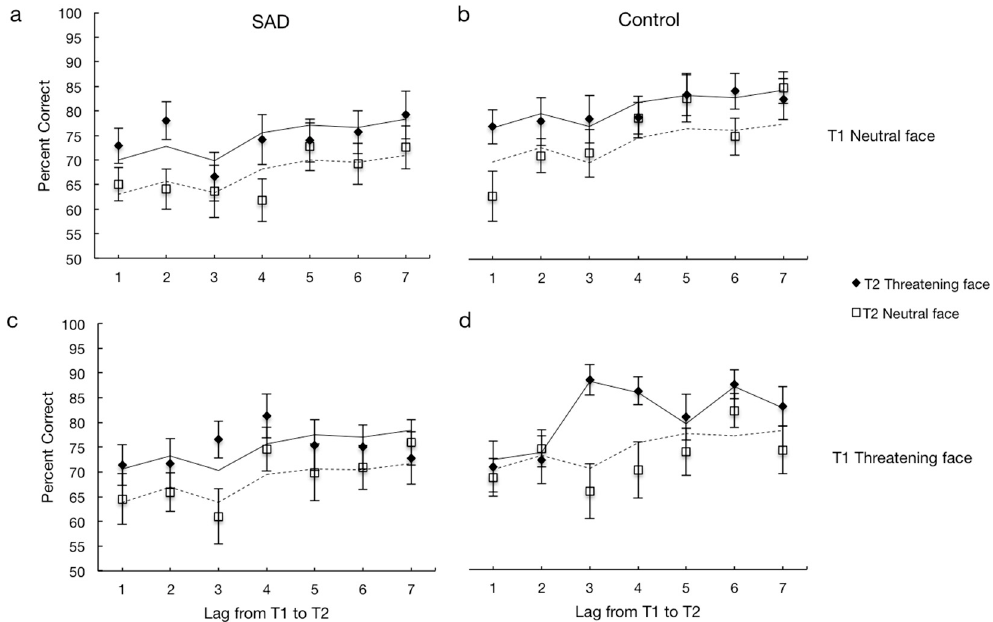
Figure 3. The results for the attentional blink task showing accuracy for T2 when T1 was correct for the SAD group when T1 was neutral ( a ) and when T1 was threatening ( c ), and for the healthy control group when T1 was neutral ( b ) and when T1 was threatening ( d ). Symbols represent the data and the lines represent predictions from the best fitting statistical models (see text for details). Error bars denote SEMs.